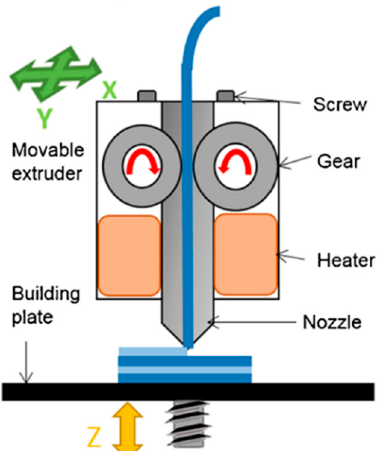
Figure 8. Mechanism of a Fused Deposition Modelling (FDM) 3D printer (Reproduced with permission from reference [47], Springer, 2016).